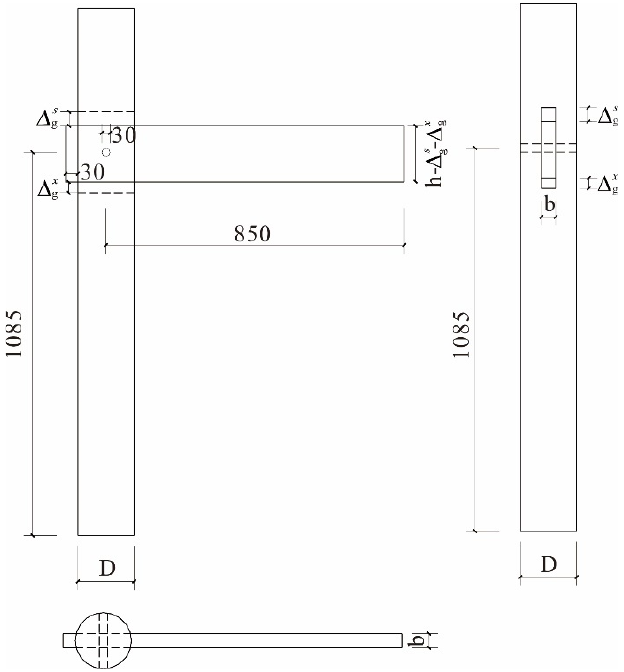
Figure 10. Specimen size and the details of the joint. Note: h − ∆ s g − ∆ x g is the beam height after the radial shrinkage deformation perpendicular to the grain of the wood.